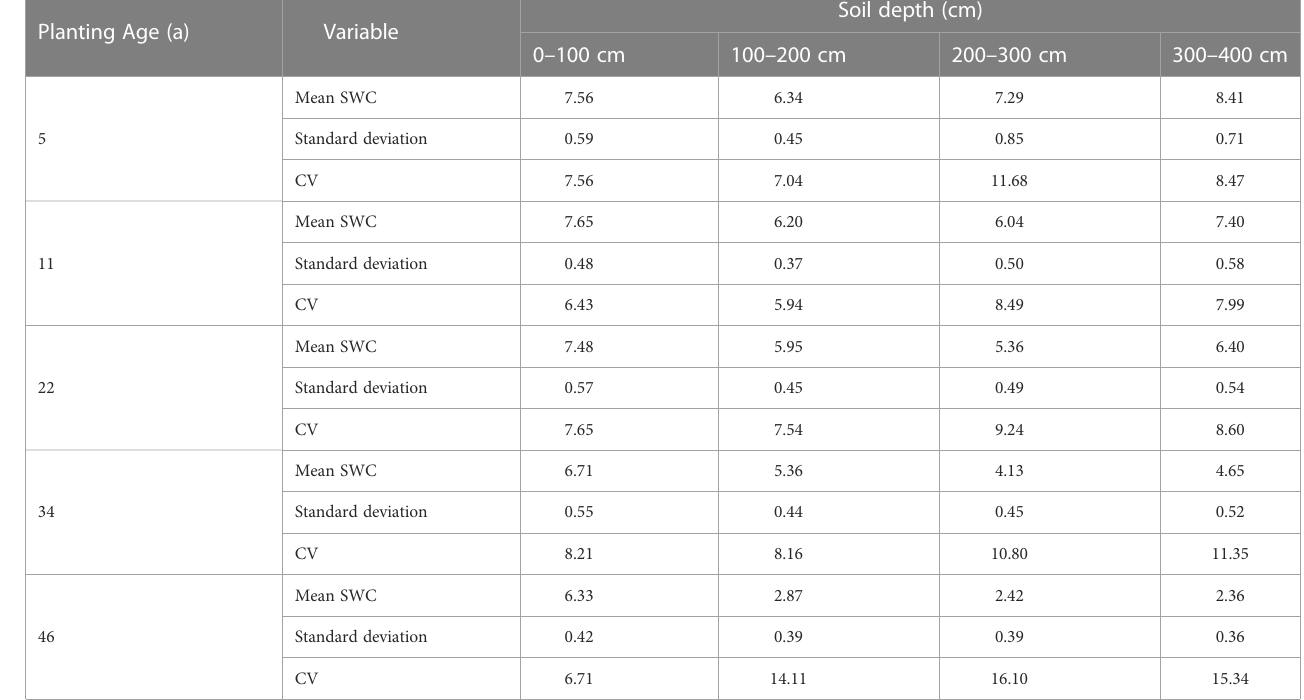
TABLE 2 Spatial statistical characteristics of temporal average, standard deviation and coef fi cient of variation (CV) of SWC in different soil layers.